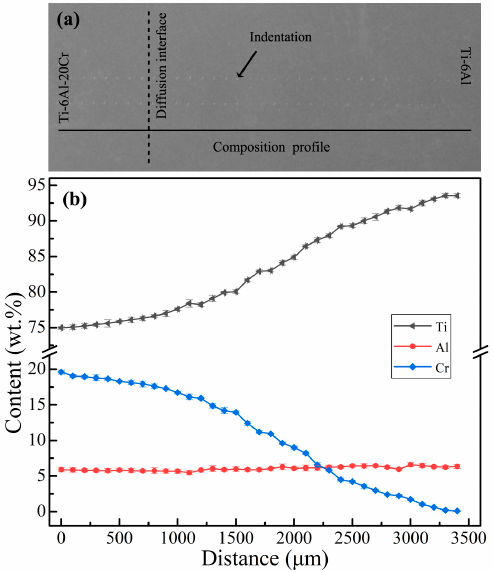
Figure 1. Micro-hardness indentation ( a ) and variation curve of composition with diffusion distance ( b ) of the (Ti-6Al)–(Ti-6Al-20Cr) diffusion couple.